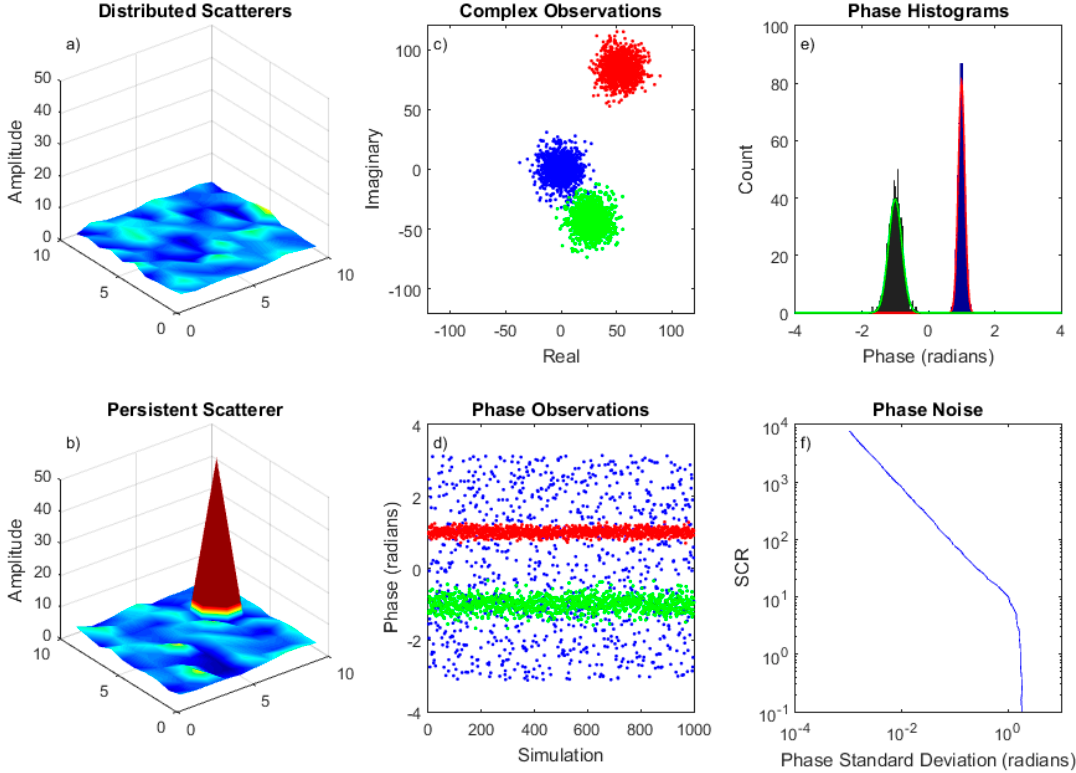
Figure 2. Simulation results of phase response within a pixel. ( a ) Visualisation of a pixel containing 100 distributed scatterers of similar amplitude; ( b ) visualisation of a pixel as before but containing one dominant PS; ( c ) complex observations for 1000 simulations for the situation with no PS (blue), a PS with an SCR of 16 and a phase of − 1 radian (green) and a PS with an SCR of 64 and a phase of one radian (red). ( d ) Phase observations for the simulations in ( c ); ( e ) histograms of the phase for the two PS simulations with the best fitting normal distribution for each; ( f ) the relationship between the SCR and the standard deviation of the phase observations estimated by fitting a normal distribution to the results of 1000 PS simulations.